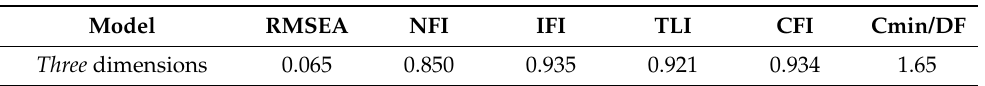
Table 5. CFA: Goodness-of-fit . Questionnaire REI ( n = 156 students of Agrarian Schools, members of FFs). Model RMSEA NFI IFI TLI CFI Cmin/DF Three dimensions 0.065 0.850 0.935 0.921 0.934 1.65